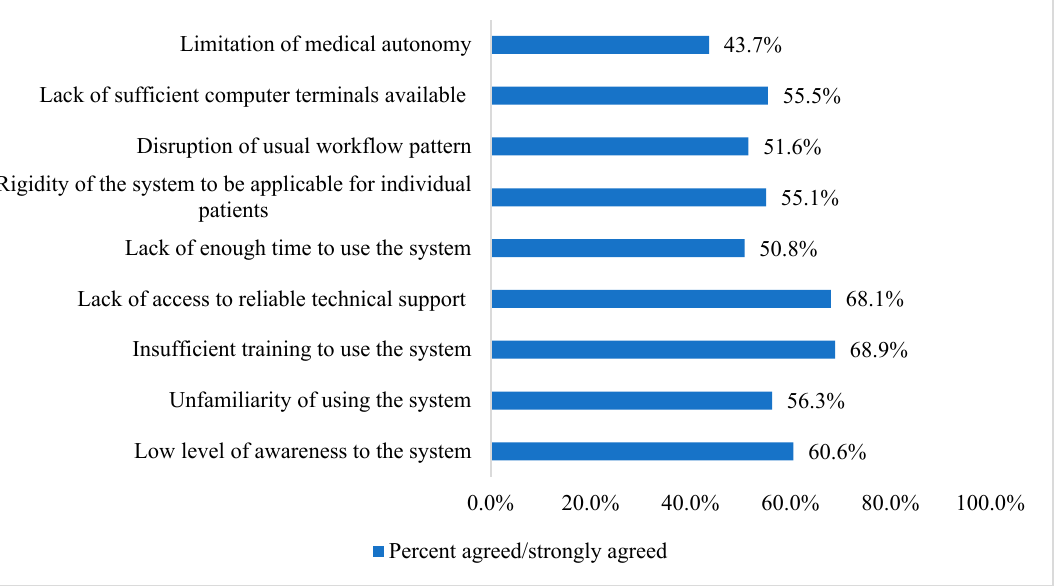
Figure 2. Participants perceived barriers to using electronic prescribing and electronic health record systems in antimicrobial stewardship ( n = 254).